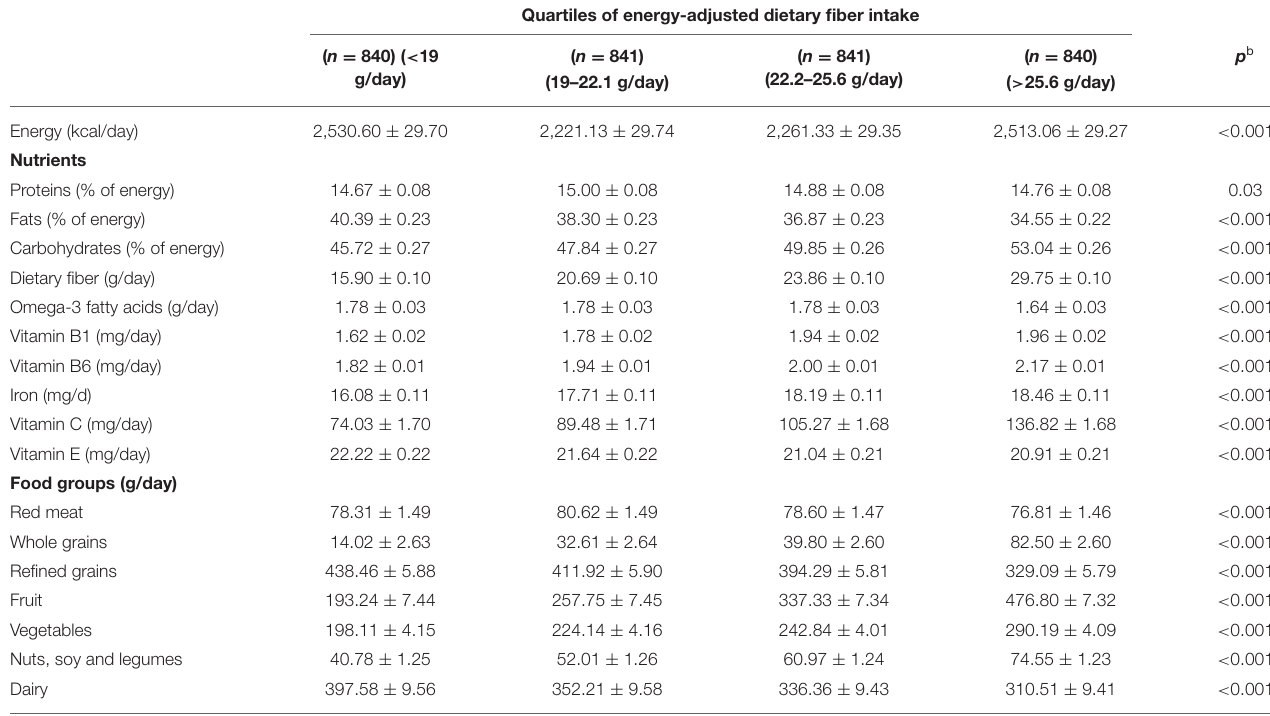
TABLE 2 | Dietary intakes of selected nutrients and food groups across quartiles of energy-adjusted dietary fiber intake ( n = 3,362) a . Quartiles of energy-adjusted dietary fiber intake